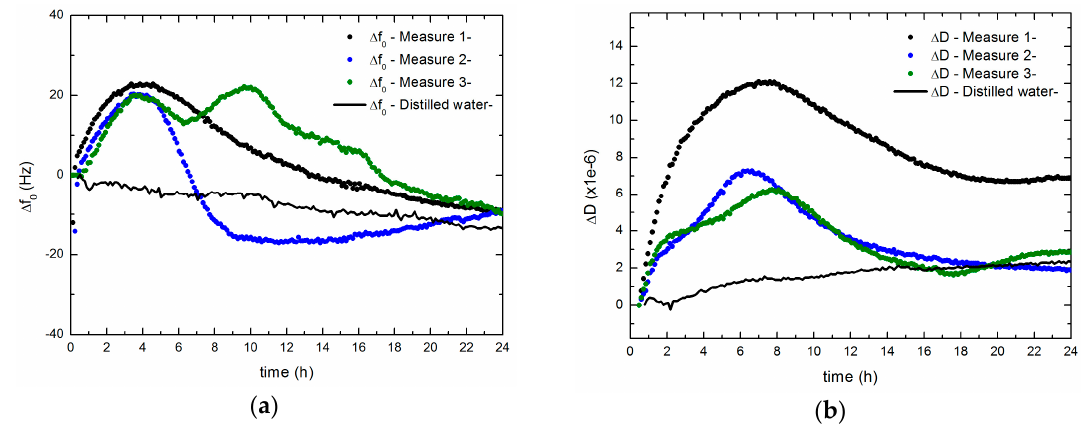
Figure 4. Biofilm formation processes of S. epidermidis ATCC 35984 ( a ) Δ ƒ 0 and ( b ) ∆ D for 3 measurements made with the quartz resonator at the fundamental frequency of 5 MHz.